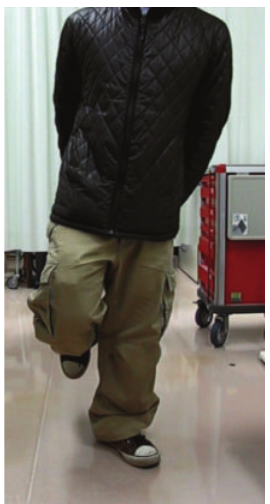
Figure 4: Photograph showed he stood on the left leg steadily with- out any support.